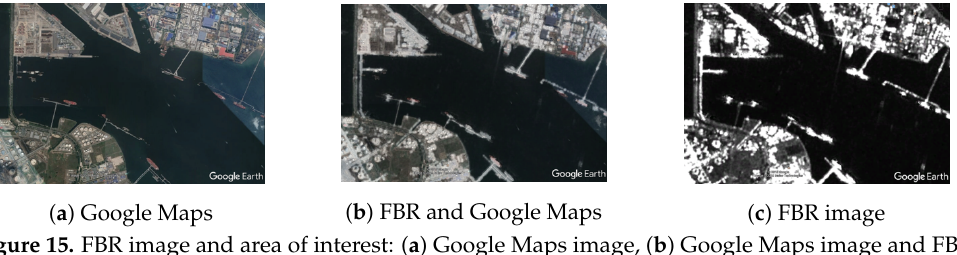
Figure 15. FBR image and area of interest: ( a ) Google Maps image, ( b ) Google Maps image and FBR image with 50% transparency, ( c ) FBR image projected on the Google Maps image.